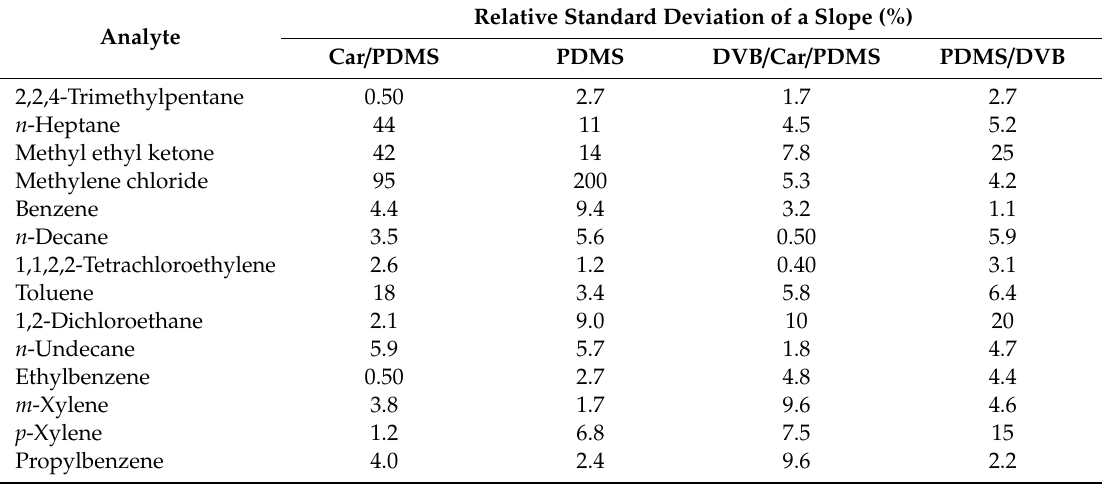
Table 4. Relative standard deviations of calibration slopes obtained using di ff erent SPME